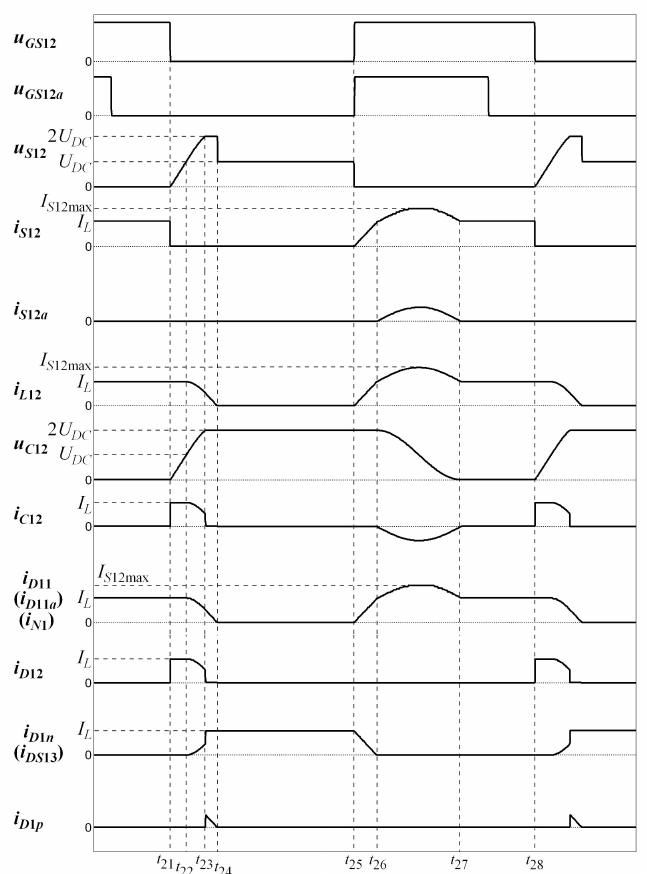
C12 is equal to zero. The load current I L flows from voltage source UDC2 through D11a, D11, L12, and S12 to the load phase A (Figure 6a).